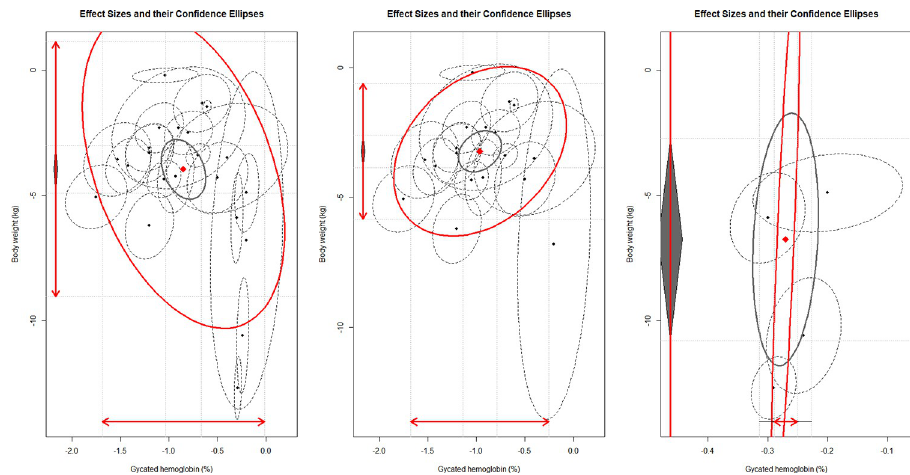
amount of between-study heterogeneity of body weight decreased from 7.36 to 1.77 and the 95% CI became narrower. The pooled correlation coefficient turned to a positive estimate of 0.32. There were only five studies focused on participants without diabetes. The pooled HbA1c change by GLP1-RA was -0.27% (95% CI [-0.31%, -0.23%], I 2 = 13%), the pooled body weight change was -6.76 kg (95% CI [-10.81 kg, -2.72 kg], I 2 = 99%); the amount of between-study het- erogeneity of body weight was much increased to 20.84 with a wide 95% CI due to the limited included articles. However, the pooled correlation coefficient was positive of 0.81. The pooled results for all participants and the results restricted to patients with diabetes are shown in Fig 3. Sensitivity analyses of all participants and patients with diabetes by setting the correlation coefficient to 0.1 and 0.3 and restricting the study selection to studies with a low risk of bias